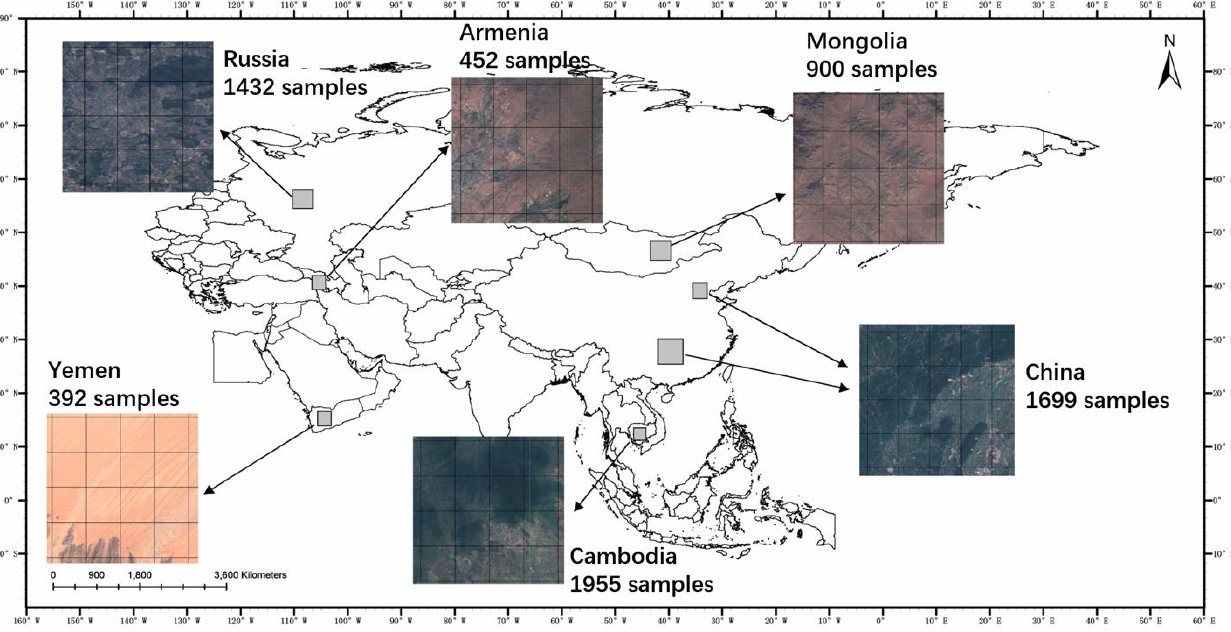
Figure 2. The proportions of land cover types. 2.2. Dataset All the images in the datasets were clipped with a grid of 1024 × 1024 pixels, obtaining 6820 sample images in total. The datasets used in this study include Sentinel-2 image, Esri 2020 Land Cover, and OSM data, as shown in Table 1. Table 1. Details of the datasets used in this study. Dataset Data Time Data Type